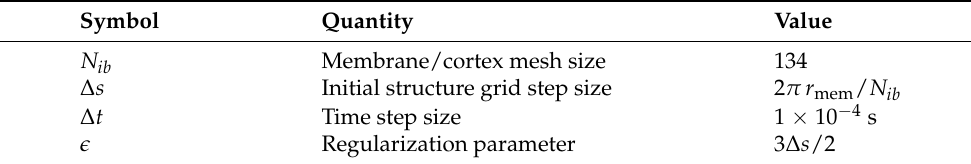
Table 2. Computational and discretization